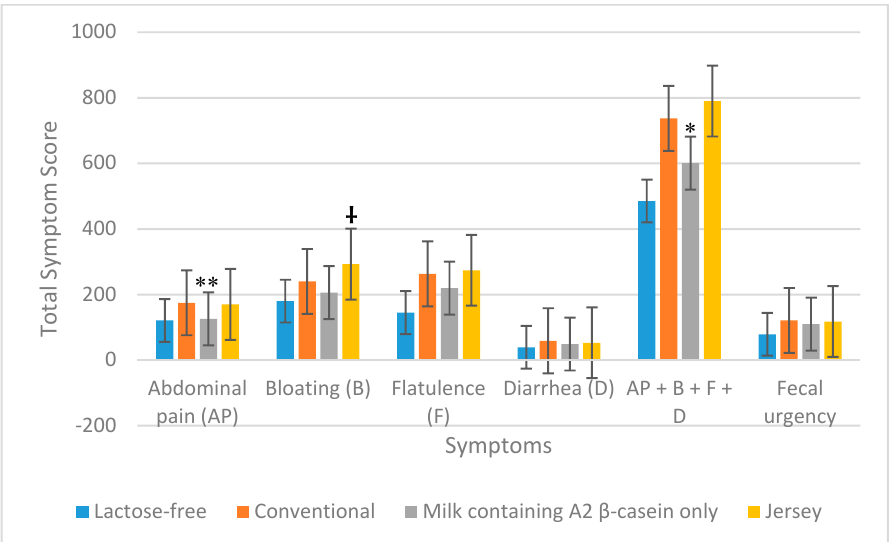
Figure 3. Total symptoms reported during the 6 h after consuming the four milk products in 33 lactose maldigesters. ** p = 0.001 for abdominal pain and * p = 0.04 for total symptoms (abdominal pain + bloating + flatulence + diarrhea) due to milk containing A2 β -casein only vs. conventional milk; † p = 0.05 for bloating due to Jersey milk versus conventional milk.